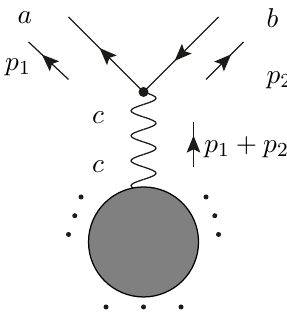
Figure 1 . Feynman diagrams leading to soft gaugino singularities.